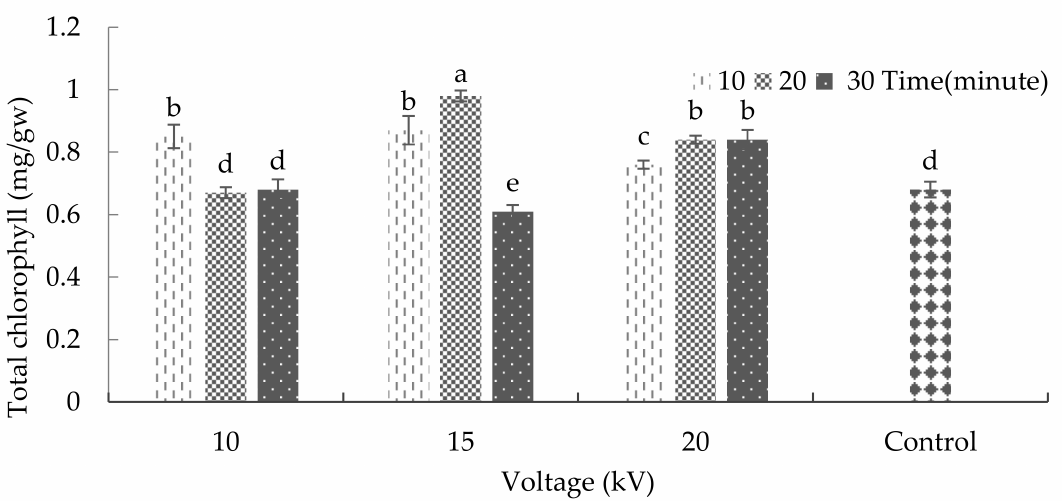
Figure 5. The effect of plasma on the total chlorophyll content of basil. Error bars indicate standard error ( n = 3). Different lowercase letters denote statistical differences between treatment groups at the 5% level according to Duncan’s test.